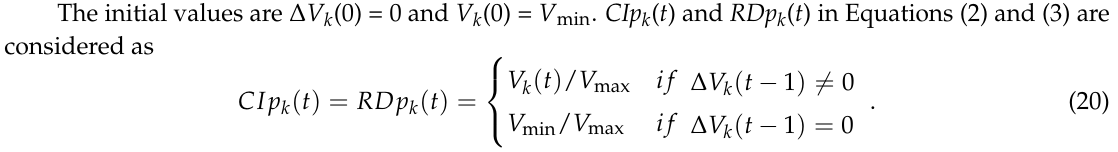
Table 4. Variable settings.